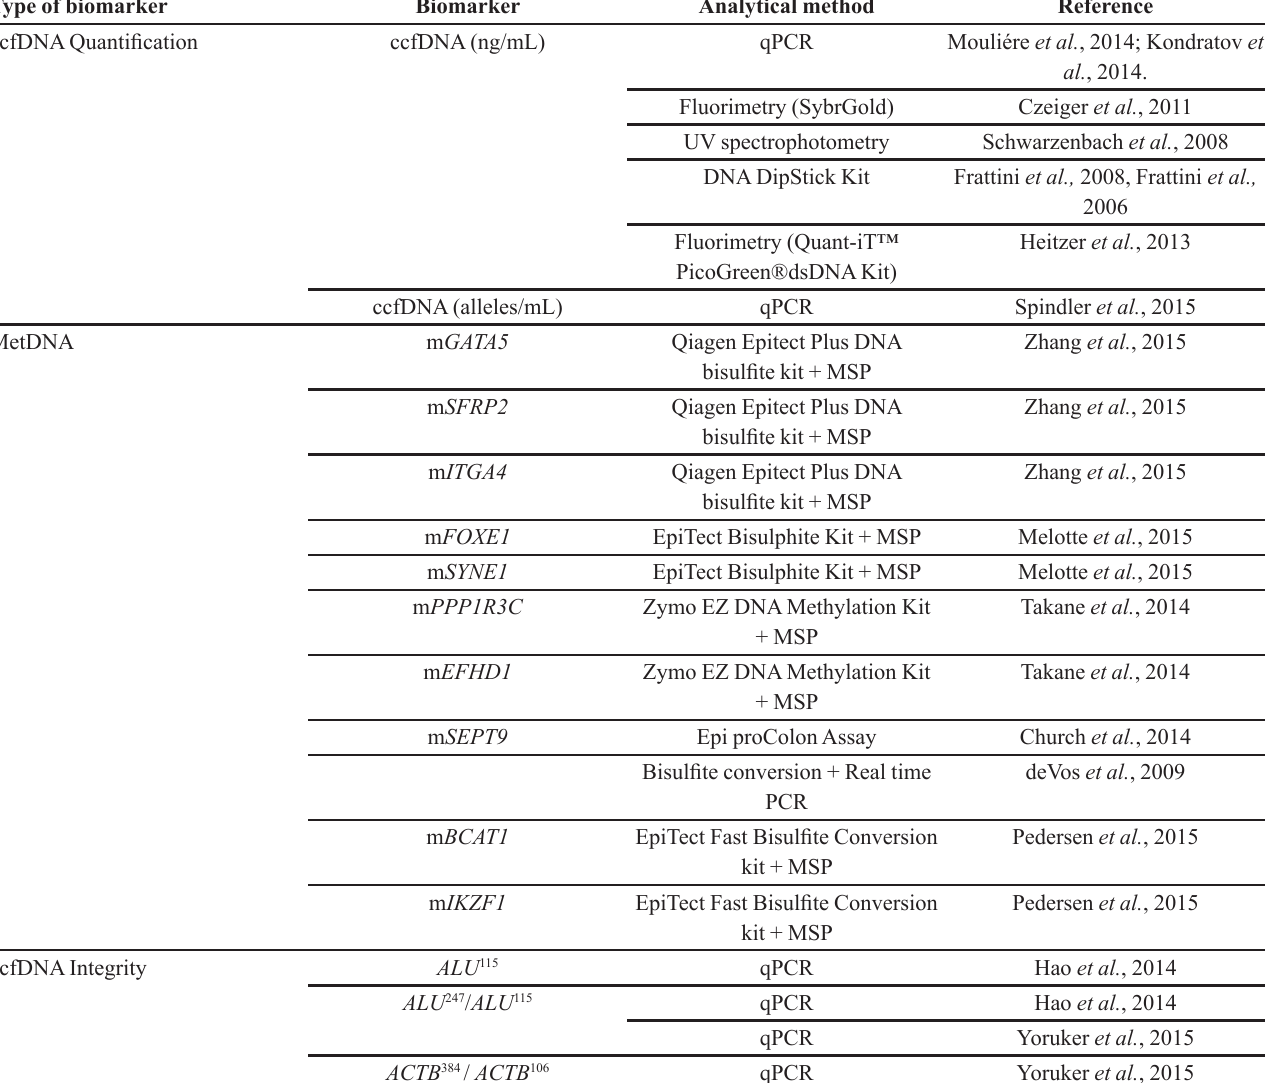
TABLE I - Analytical Methods for the quantification of ccfDNA and other biomarkers in the CRC